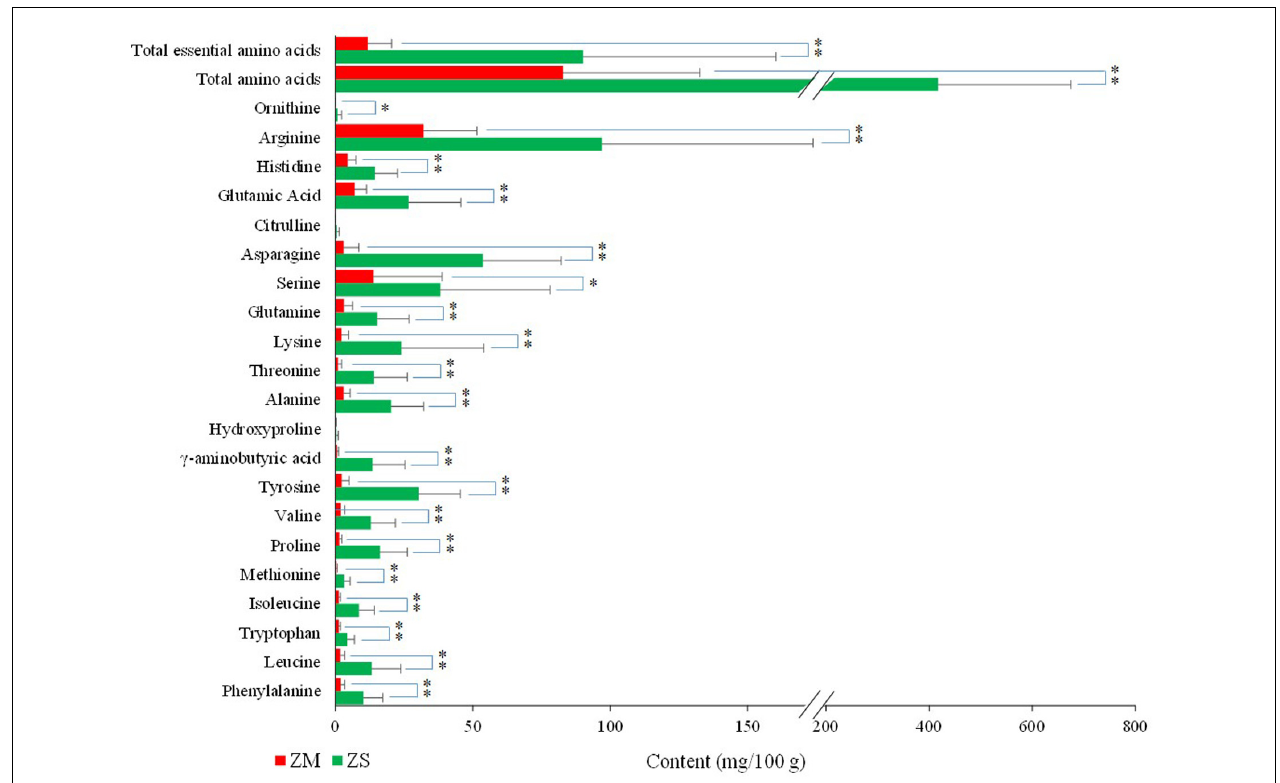
FIGURE 3 | Contents of free amino acids (mg/100 g) in the seeds of Ziziphus jujuba var. spinosa (ZS) and Z. mauritiana (ZM). ∗ P < 0.05, ∗∗ P <